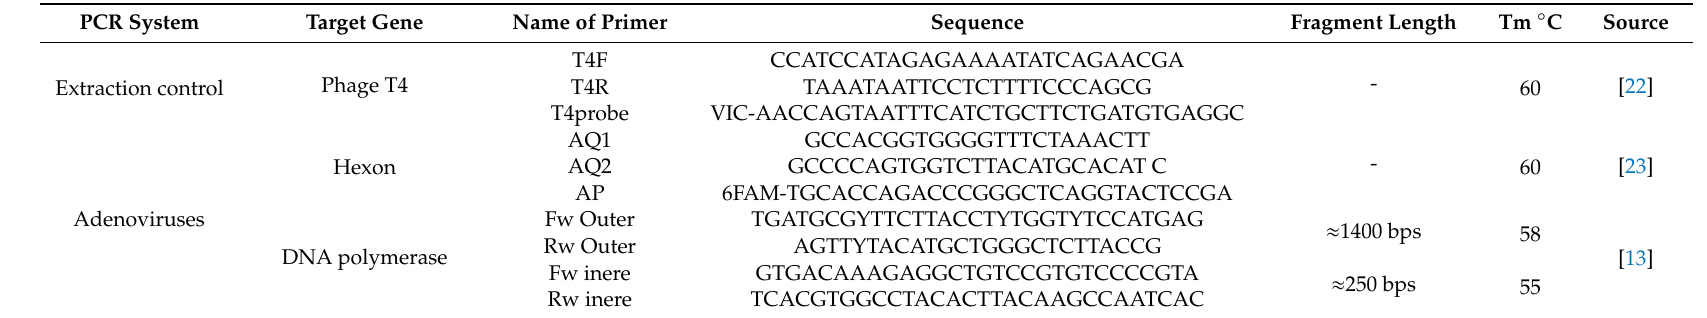
Table 1. PCR systems used in the present